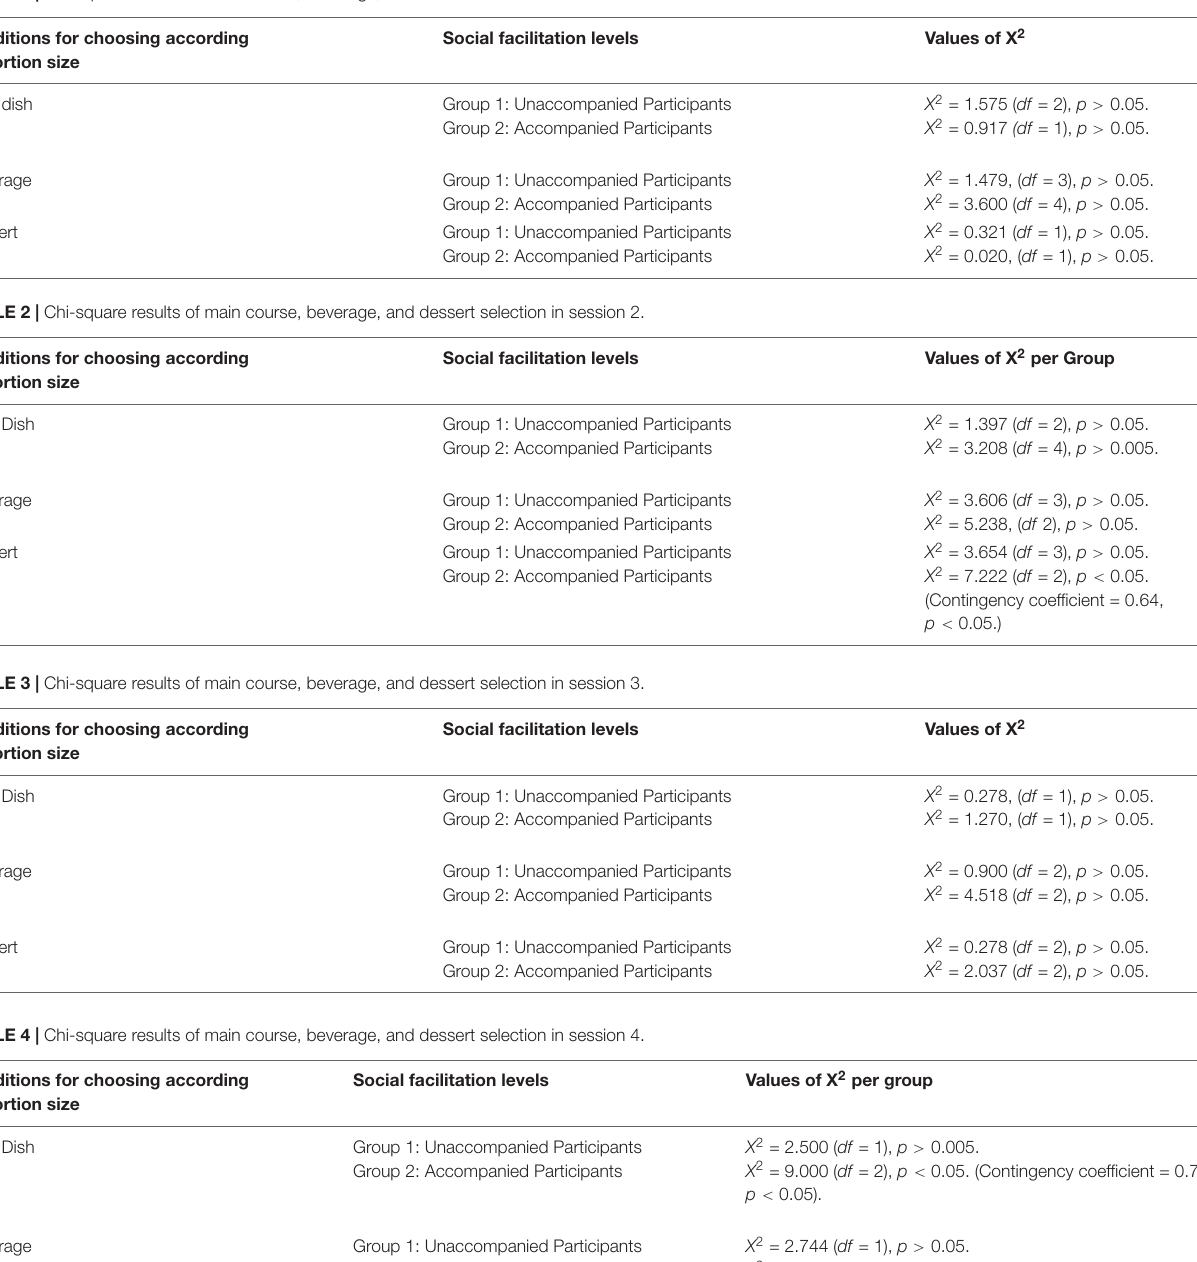
TABLE 1 | Chi-square results of main course, beverage, and dessert selection in session 1.